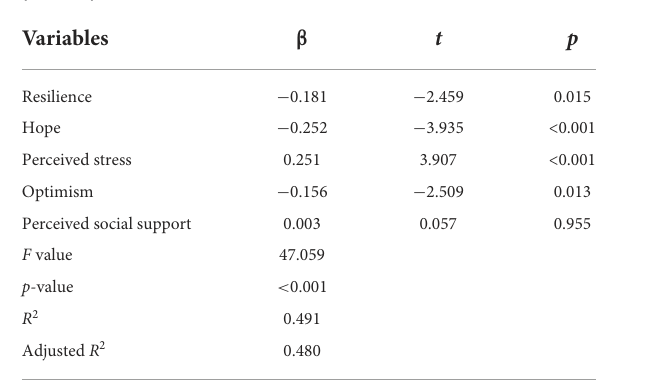
TABLE 5 Multiple linear regression analysis on results of anxiety ( n = 250).